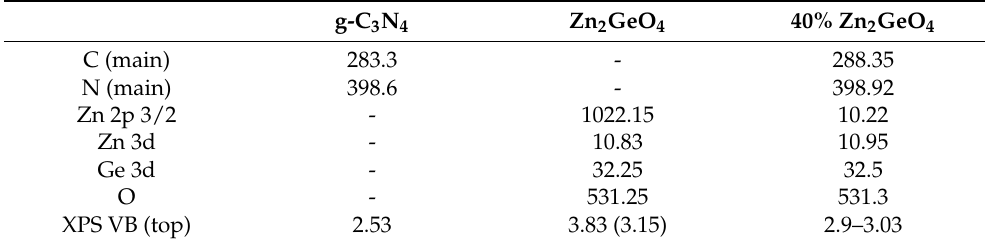
Table 1. BE values (in eV) after correcting for charging by assuming the C 1s of adventitious carbon (indicated as CH in Figure 2a) to be at 284.8 eV (with reservation that this value is not necessarily the correct one for the present systems).